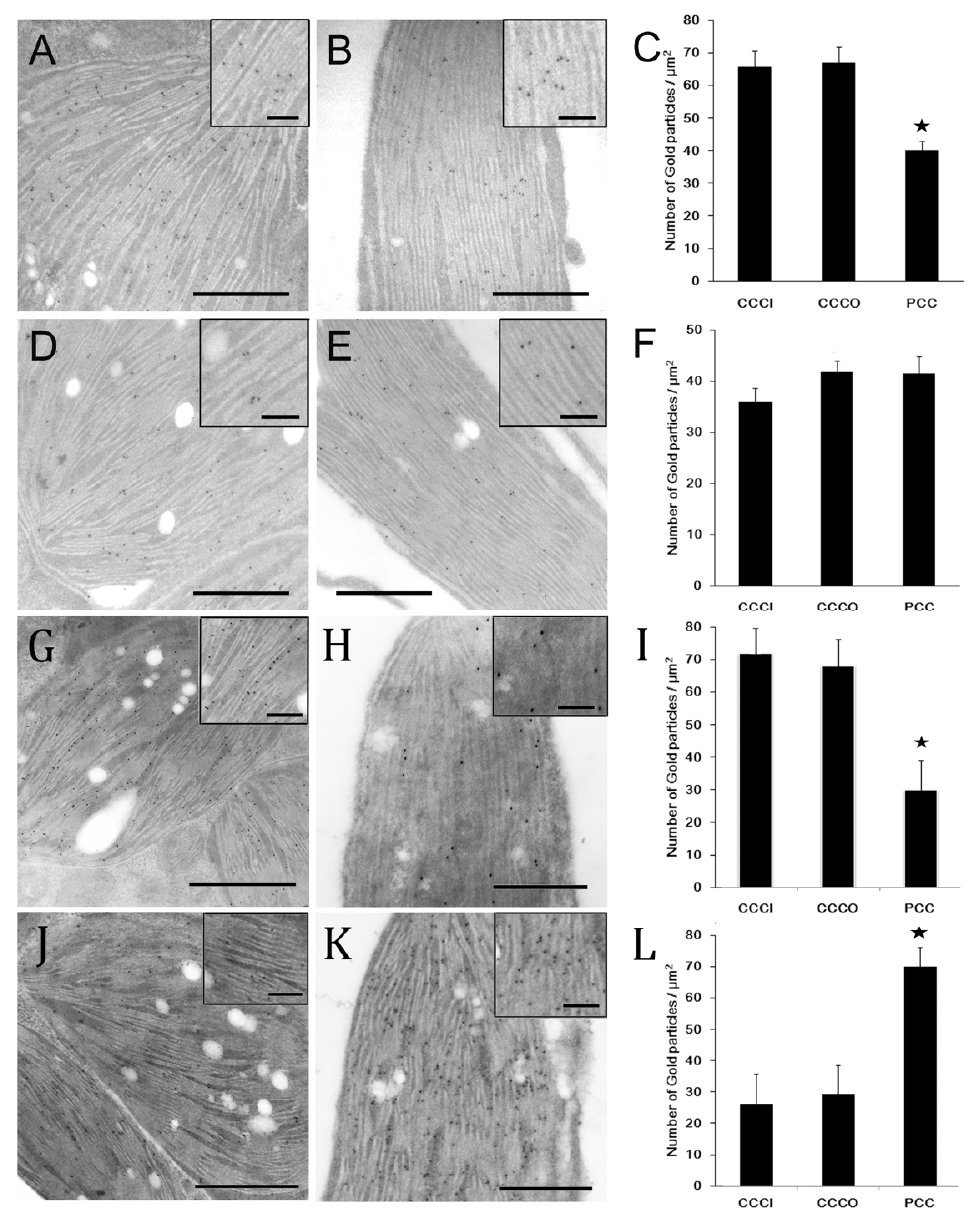
Figure 5. Immunolocalization and quantification of PsbO, cytochrome f, PsbA and PsaB in chloro- plasts in mature leaves of B. sinuspersici . Immunolocalization and quantification of ( A – C ) PsbO, ( D – F ) cytochrome f, ( G – I ) PsbA, and ( J – L ) PsaB in chloroplasts of mature leaves. Images are trans- mission electron micrographs of ( A , D , G , J ) CCC and ( B , E , H , K ) PCC chloroplasts probed with PsbO, cytochrome f, PsbA, and PsaB antisera. Scale bars = 500 nm (100 nm for insets). Gold particles were counted and expressed as particle number per unit area ( μ m 2 ) in chloroplasts in 25 cells from three different bioreplicates ( C , F , I , L ). Mean ± SE. Stars represent a significant difference using the Stu ‐ dent’s t ‐ test ( p < 0.01). CCC, central cytoplasmic compartment; CCCI, CCC inner; CCCO, CCC outer; PCC, peripheral cytoplasmic compartment.